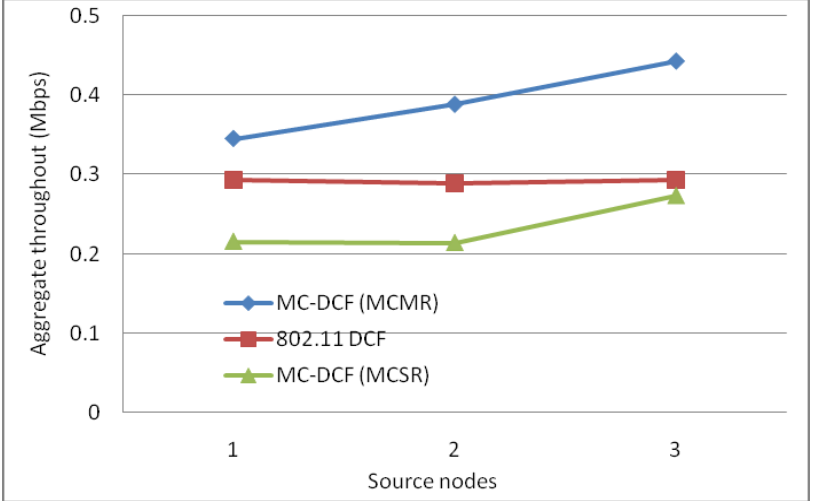
Figure 9. Throughput impact with multichannel multi-radios communication at sink